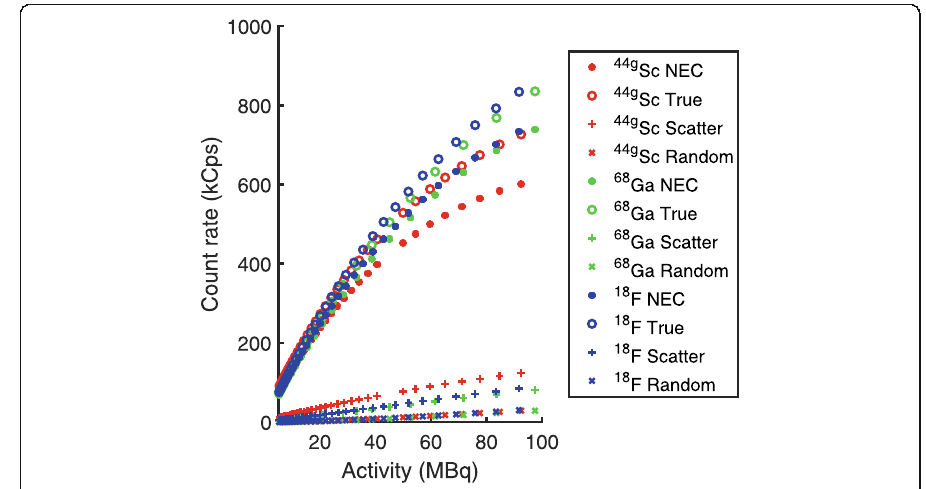
Fig. 7 Event count rates as a function of radionuclide